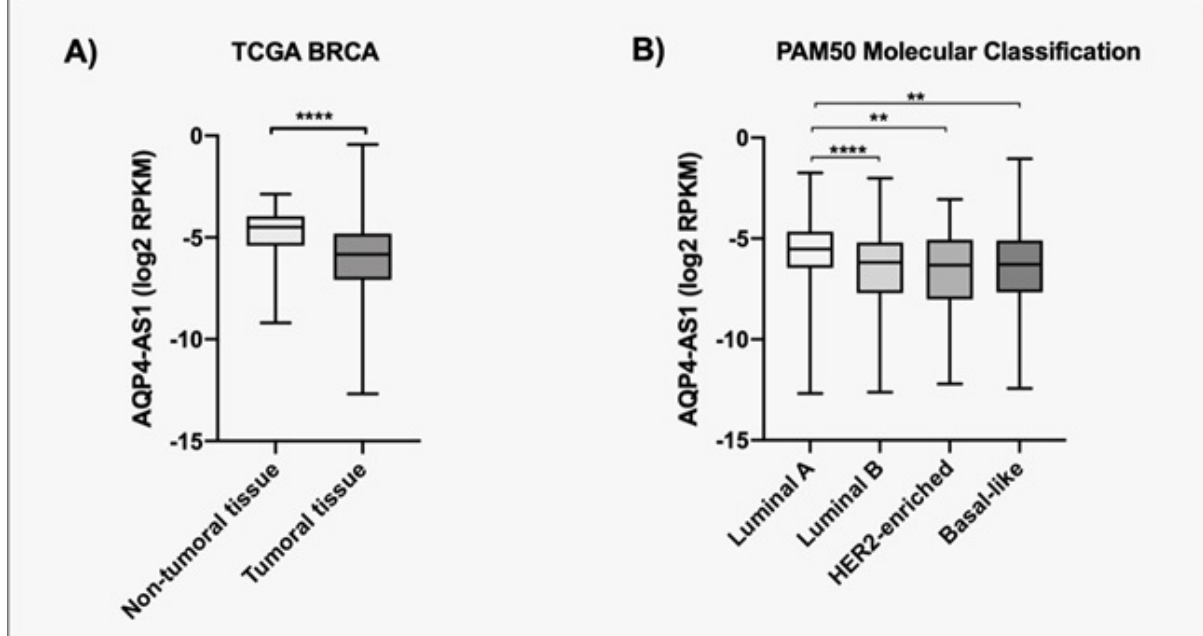
Figure 2 – Expression of AQP4-AS1 in TCGA data. A . Expression of AQP4-AS1 in non-tumoral tissue and tumor. B. Expression of AQP4-AS1 in different molecular subtypes of breast cancer. ** p < 0.001 *** p < 0.0004, **** p < 0.0001.